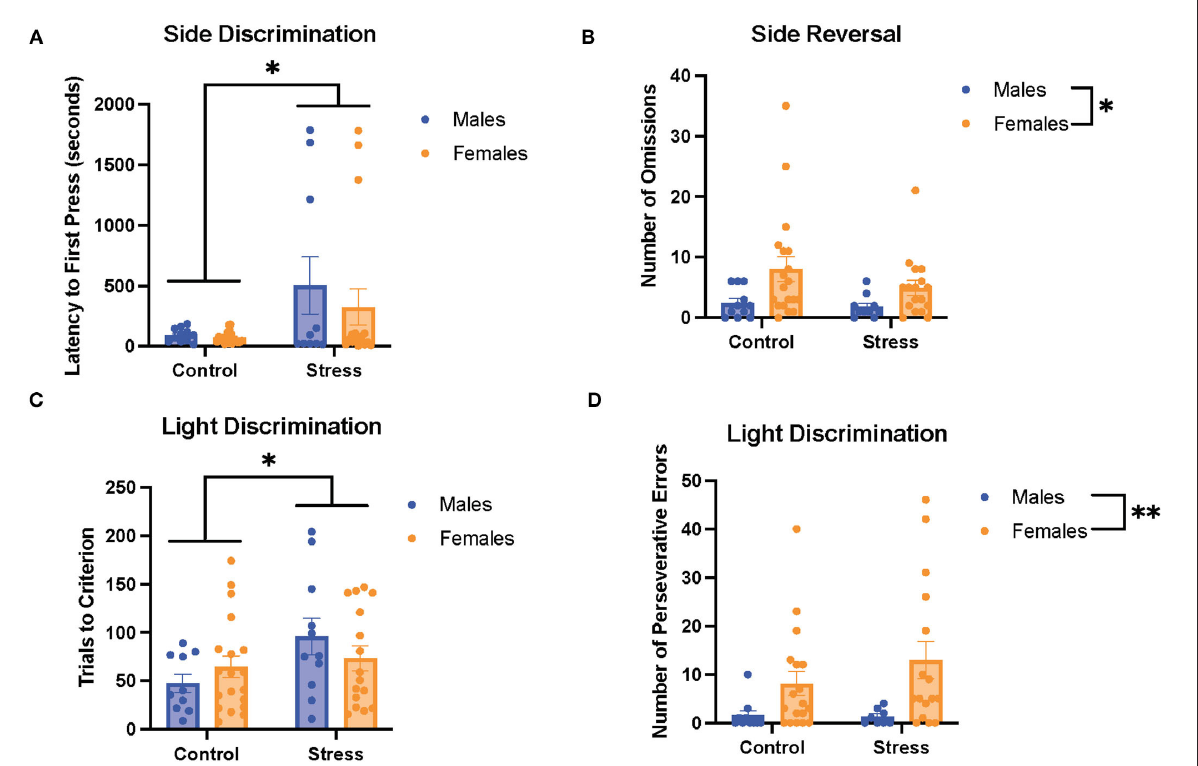
FIGURE4 Acute stress and sex impacted performance in the side discrimination, side reversal, and light discrimination tasks. (A) Stress increased latency to first press in the side discrimination task in both sexes. (B) Female rats exhibited a higher number of omissions than male rats in the side reversal task regardless of stress condition. (C) Acute stress increased trials to criterion in the light discrimination task (main effect of stress). (D) Female rats demonstrated a higher number of perseverative errors in the light discrimination task compared with male rats. Two-way ANOVAs followed by the Tukey post-hoc tests were conducted to examine the relationship between stress and sex, and the interaction between the two variables on the measurements of task performance for the male rats ( n = 21, control = 11, and stress = 10) and female ( n = 40: control = 20, and stress = 20) rats. Error bars are plotted as mean ± SEM. * p < 0.05 and ** p <